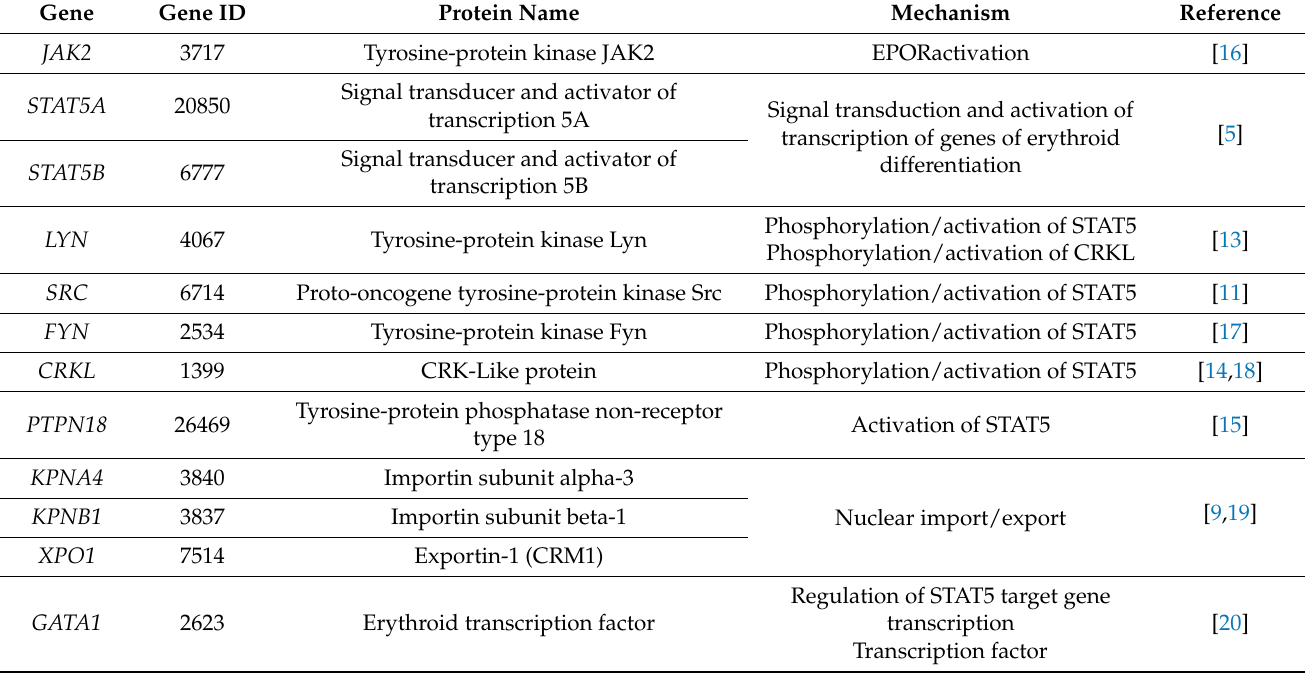
Table 1. Main players of JAK2/STAT5 signaling